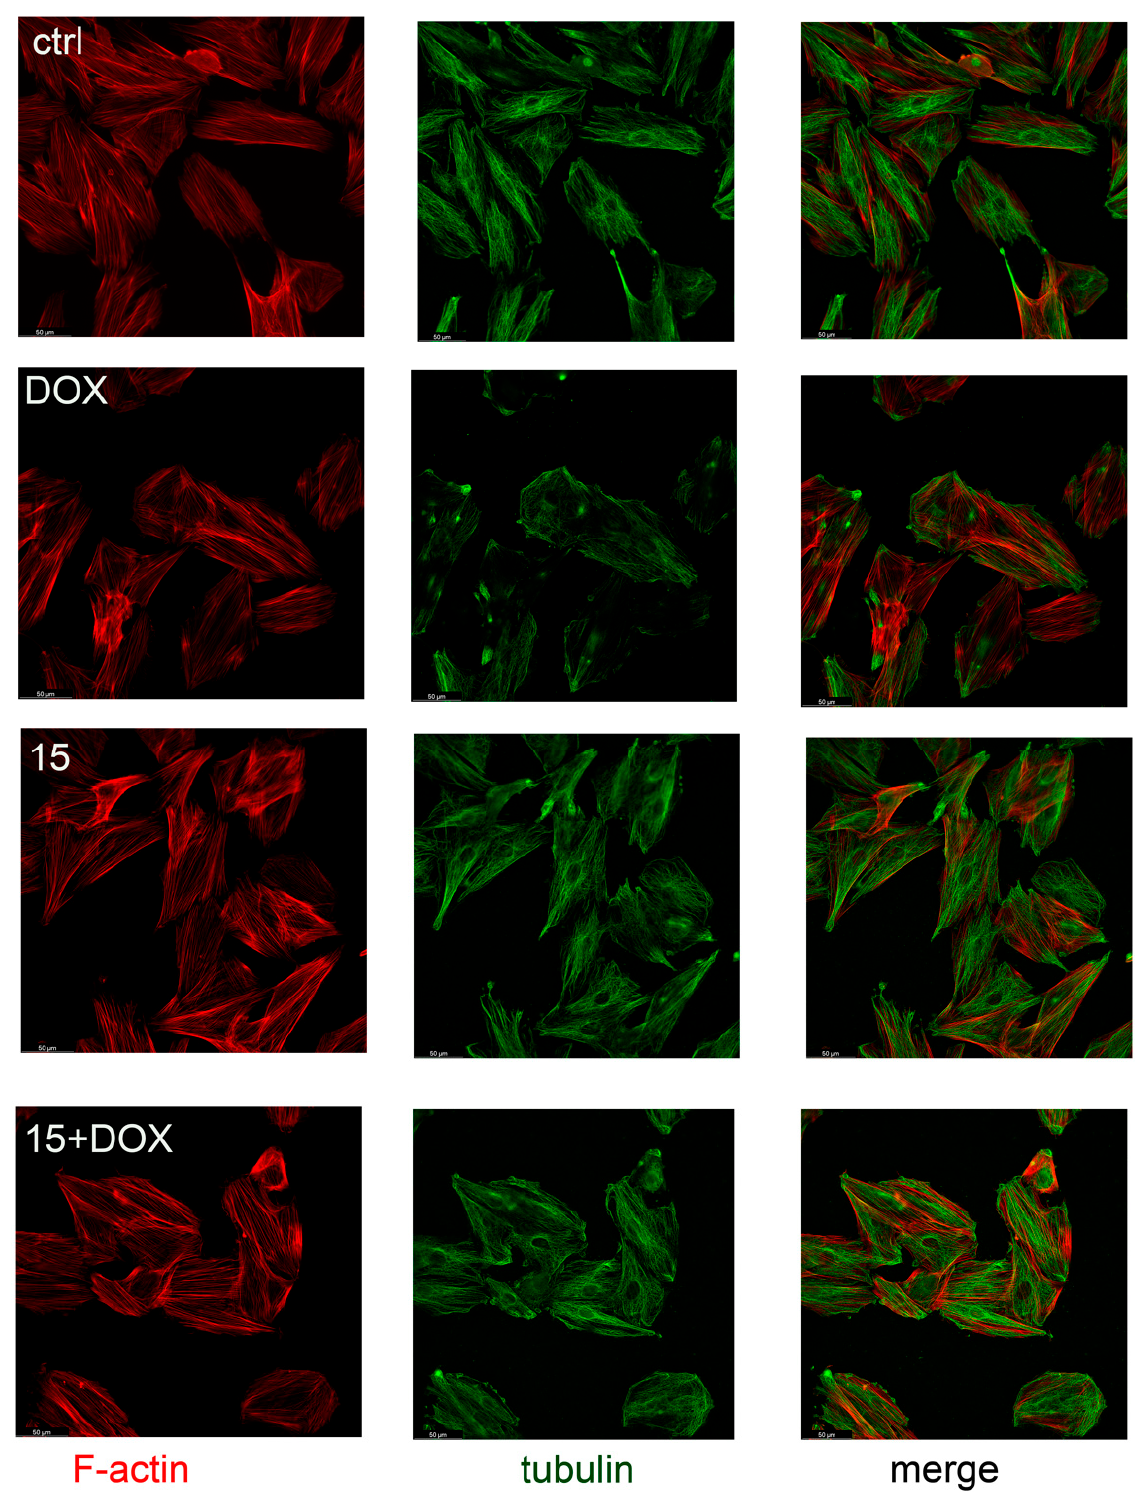
Figure 4. Compound 15 protected rat cardiomyocytes’ (H9c2) cytoskeletons from DOX-induced damage. Pictures show the changes in the actin and microtubule cytoskeletons of rat cardiomyocytes (H9c2) preincubated with compound 15 at a concentration of 25 µ M for 8 h and then exposed to DOX at a concentration of 0.5 µ M for next 16 h. Controls were: cells exposed only to the culture medium (ctrl), cells exposed only to DOX (DOX), and cells exposed only to compound 15 . Bar = 50 µ